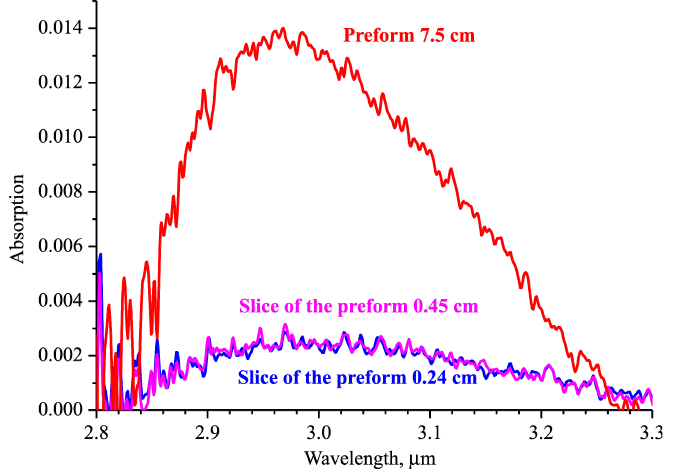
Figure 3. Absorption spectra within hydroxyl groups band of the 7.5 cm long preform and of the slices 0.24 cm and 0.45 cm thick.